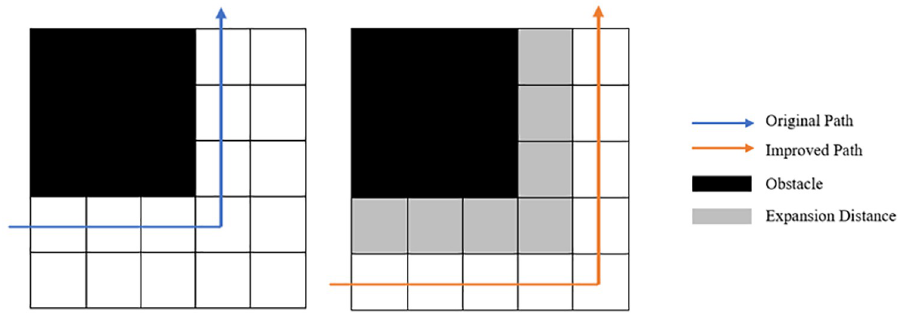
Fig 1. Schematic diagram of expansion